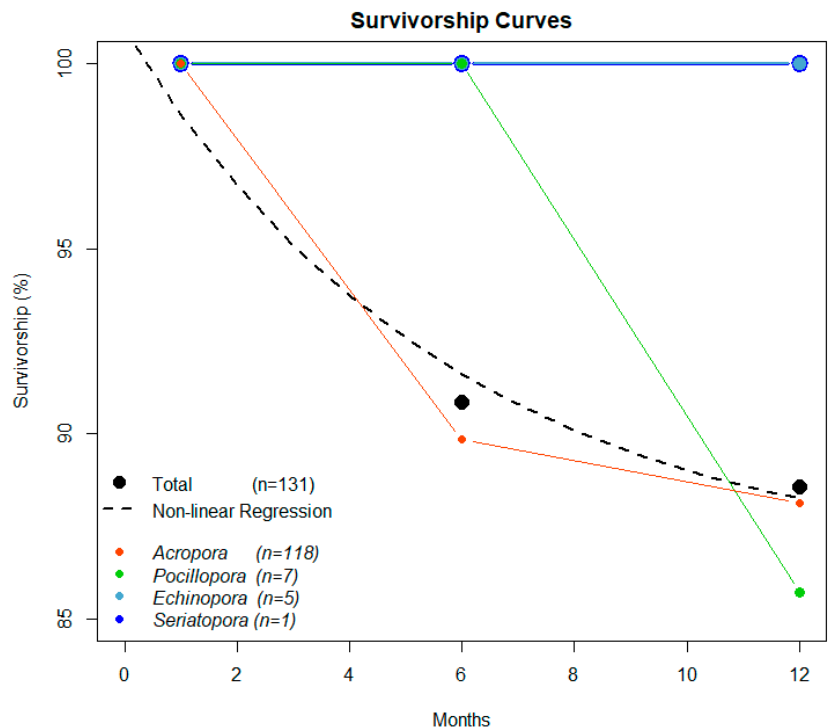
Figure 11. Survivorship of propagated corals on the Coral Greenhouse at 1, 6, and 12 months. Non-linear regression was conducted by minimising the residuals of the form Survival = ae ˆ ( k × Months ) + c where a , k and c are constants. R-squared = 0.96. The number of hard coral recruits on control and treatment plots averaged 1.8 (±0.59